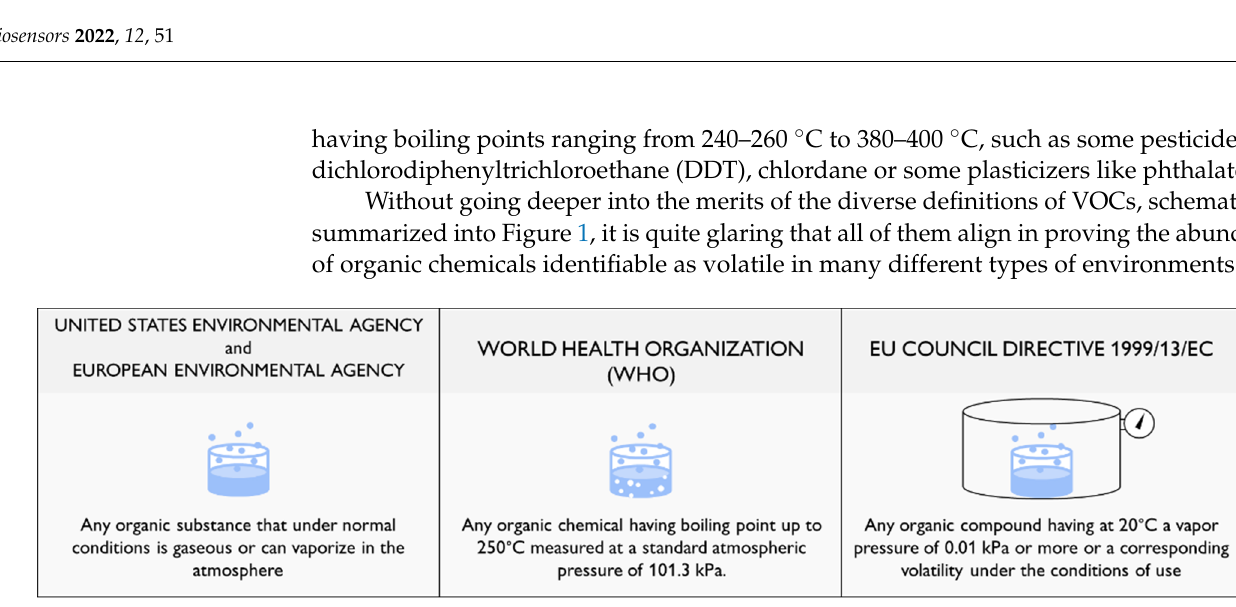
Figure 1. Definition of VOCs according to the United States Environmental Agency (EPA) and the European Environmental Agency (EEA), the World Health Organization (WHO) and the EU Council Directive 1999/13/EC.